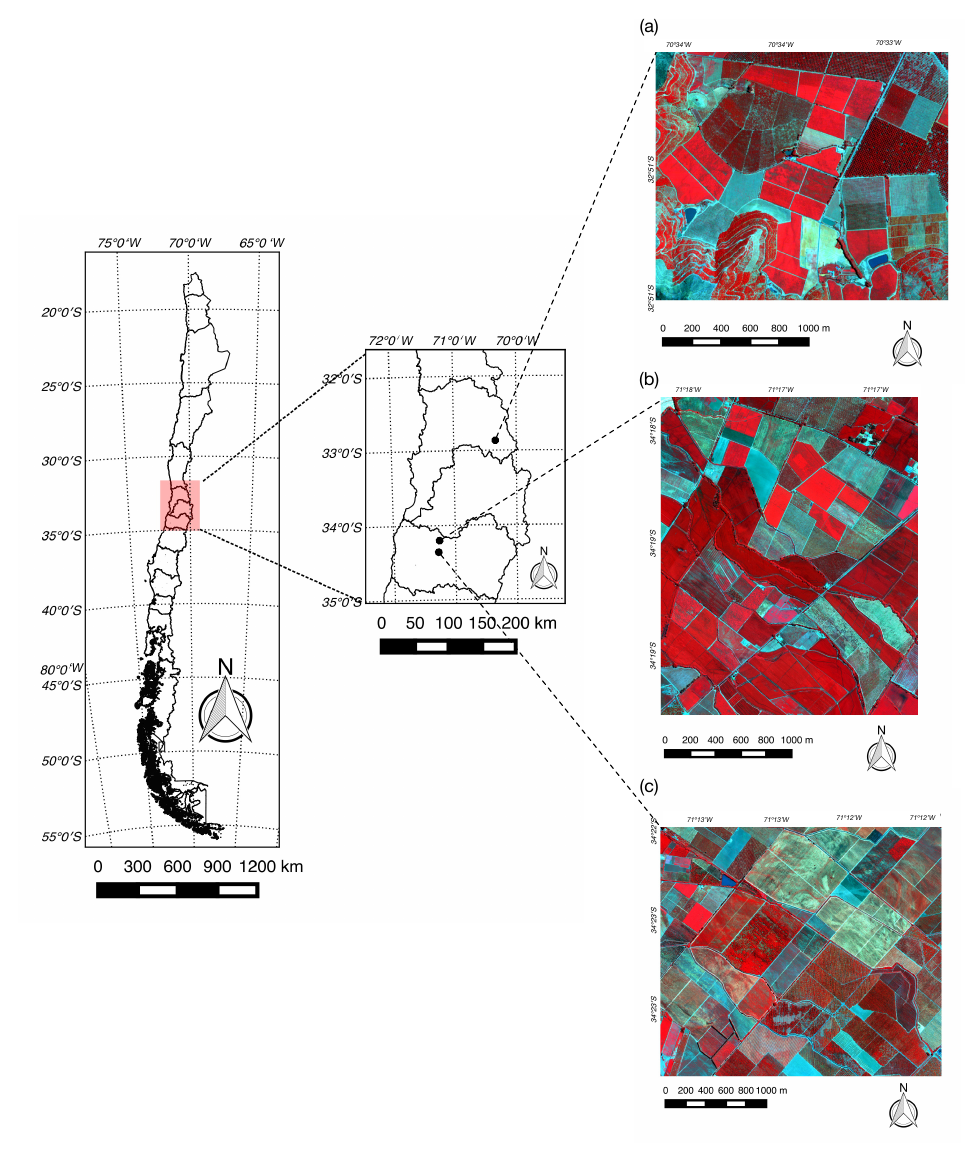
Figure 3. Source images: ( a ) QuickBird–2 (QB) Agricultural, located at 32 ◦ 51 (cid:48) S :70 ◦ 34 (cid:48) W ; ( b ) Worldview–2 (WV) Agricultural 1, located at 34 ◦ 19 (cid:48) S:71 ◦ 17 (cid:48) W; and ( c ) WV Agricultural 2, located at 34 ◦ 23 (cid:48) S:71 ◦ 13 (cid:48)